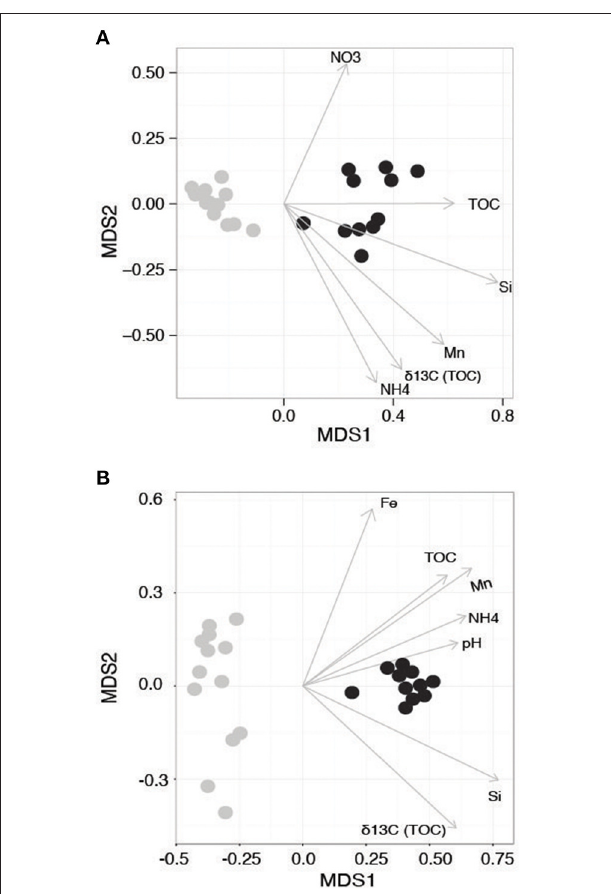
FIGURE 2 | Non-metric Multidimensional Scaling (NMDS) ordination of the beta diversity of the (A) 16S and (B) 18S rRNA-defined communities. Samples from Western Antarctica (WA) are gray and Antarctic Peninsula (AP) samples are black. Arrows denote environmental gradients that statistically correlate with the